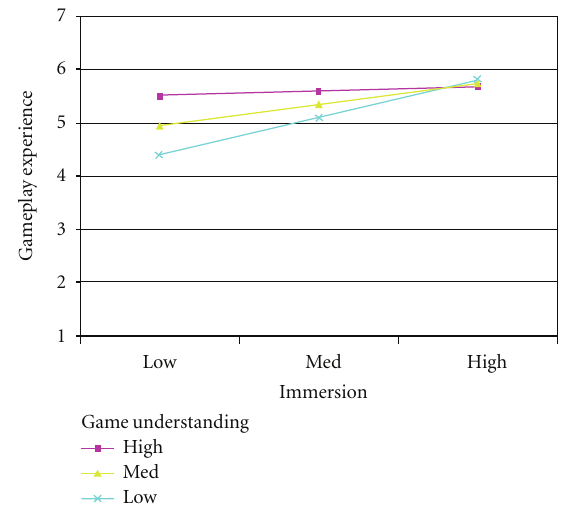
Figure 5: Interaction between immersion and game understanding on gameplay